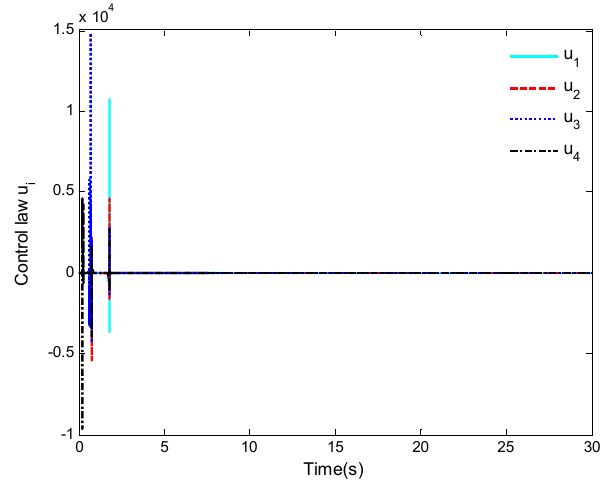
Figure 7. The curves of the control law u i